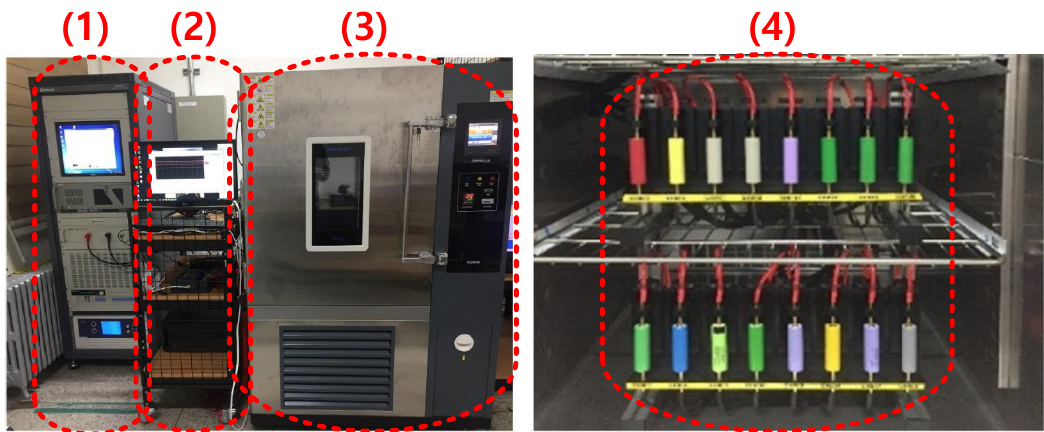
Figure 3. Experimental setup: (1) bidirectional DC/DC converter, (2) personal computer (PC) for data acquisition, (3) temperature chamber, and (4) tied battery cells inside the temperature chamber.